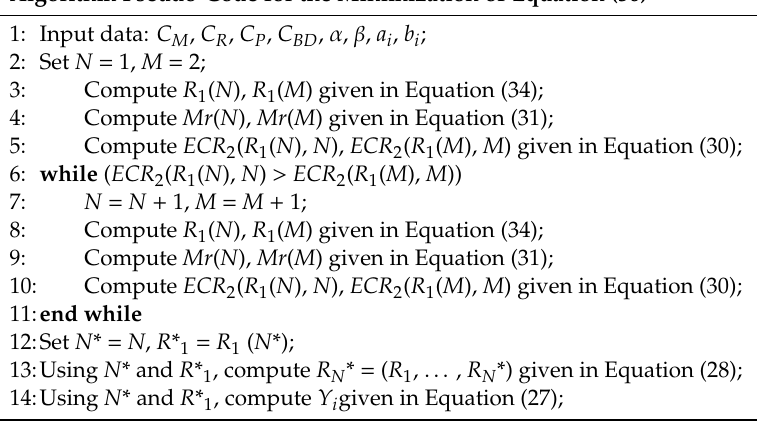
Table 3. Algorithm to obtain the optimal solution for strategy 2. Algorithm Pseudo-Code for the Minimization of Equation